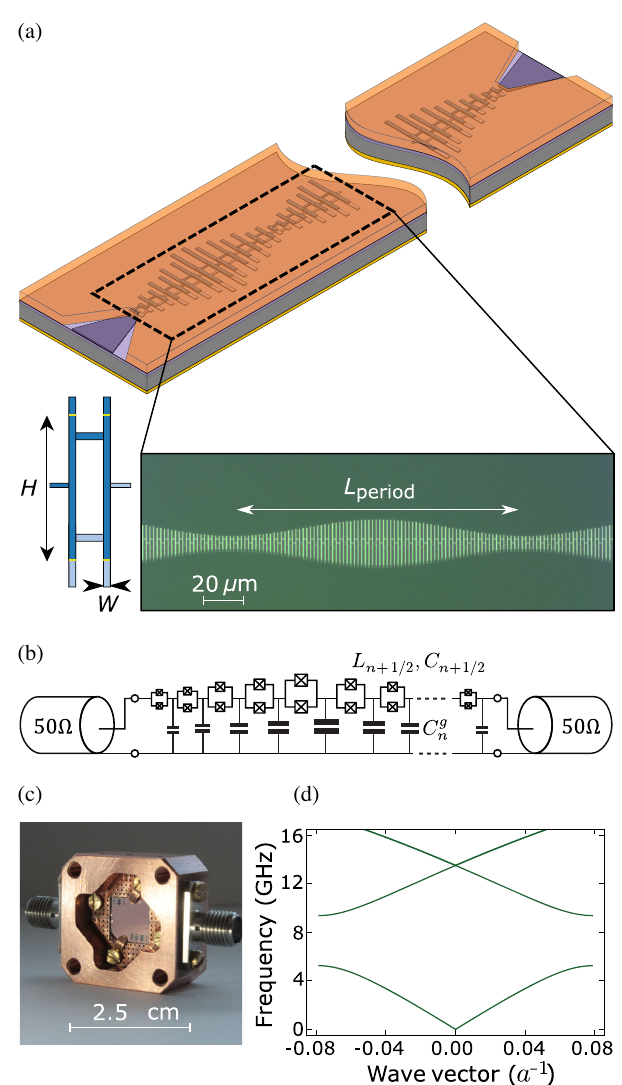
FIG. 1. (a) Schematic of the photonic crystal STWPA. The spatially modulated SQUID array is fabricated on a silicon substrate. SQUID are then covered by a thin alumina layer (purple, obtained via atomic-layer deposition) and a thick copper- layer orange, which is used as a top metallic ground. Schematic: representation of one SQUID. W denotes the junction width while H is the height of the junction, which is the overlap between the top (dark blue) and bottom (light blue) aluminum layers. More details in Sec. A. Optical picture: two periods of the SQUID array. Only the height is modulated. The modulation amplitude on the figure ( γ ¼ 60% ) is greatly exaggerated for the sake of presentation; the actual samples have γ ¼ 4% and 2%. (b) Electrical sketch of the STWPA. The electrical parameters of the unit cells are following a sinusoidal modulation. (c) Picture of the sample. The chip is the mauve square in the middle, plugged to a copper printed circuit board in its copper box. The magnetic field is applied normal to the chip using a coil directly anchored onto the copper box. (d) Dispersion relation, plotted in the first Brillouin zone, of an array of 2160 SQUID with realistic microscopic parameters and a modulation amplitude γ ¼ 60%